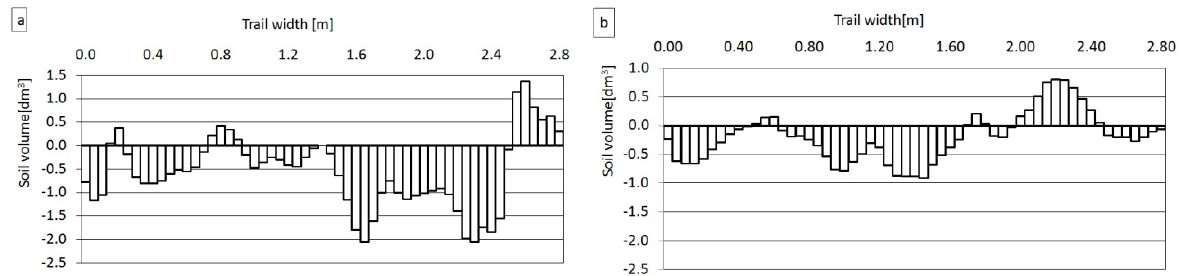
Figure 11. Changes in soil volume on trail sections before and after skidding: ( a ) Tt129U and ( b ) Tt129L. For tractor trail Tt129, a pronounced soil loss was noted in the upper (U) and lower (L) parts of the trail, especially in the longitudinal axis (R). Soil loss from trails in their deepest areas may also have been influenced by surface runoff. According to meteorological data, the period between the measurement dates (T1—29 July 2015 and T2—22 Octo- ber 2015) was marked by quite heavy rainfall reaching up to 160 mm. The highest total loss of soil from a 10-m long trail (Table 7) was observed in the upper part of the tractor trail Tt129U, amounting to nearly 1.563 m 3 , while in the lower part of the trail the loss was 0.675 m 3 (Tt129L). Significantly lower values of soil loss were recorded on horse trails, ranging from 0.129 to 0.418 m 3 . For horse trail Ht129U, nearly 15 times more soil was lost